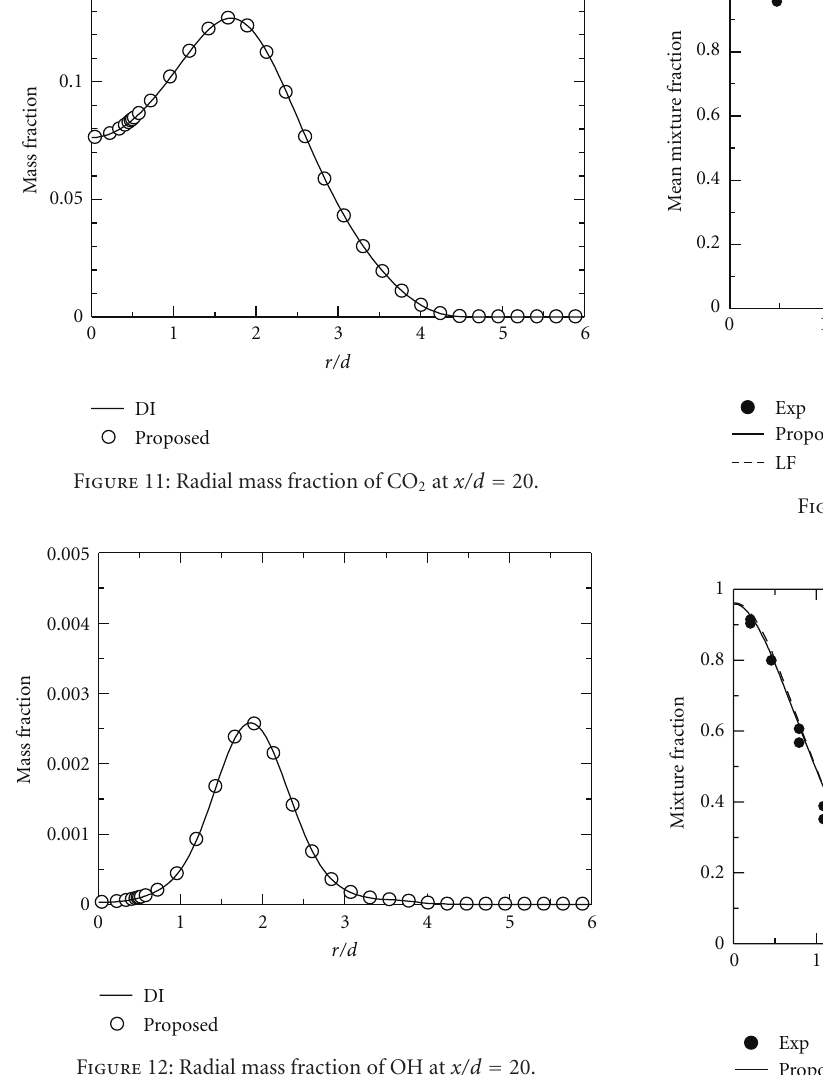
Figure 12: Radial mass fraction of OH at x/d = 20.